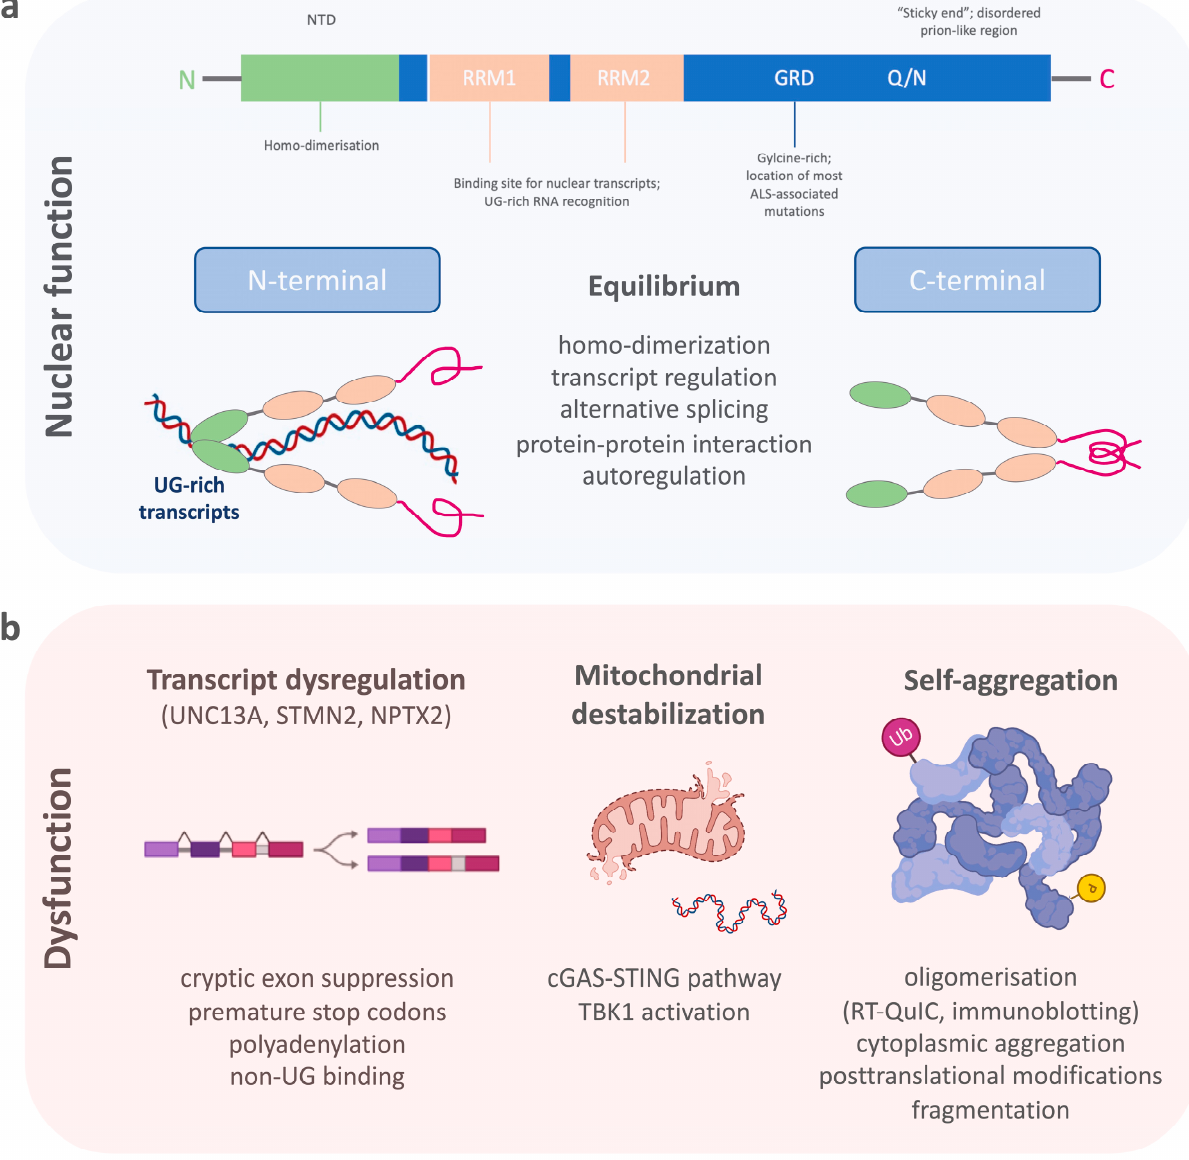
Figure 1. The schematic shows ( a ) the structure of TDP-43 and its importance for the physiological functions within the cell nucleus, and ( b ) the dysfunctional state of TDP-43 with the dysregulation of its nuclear function, destabilization of mitochondria, and its aggregation